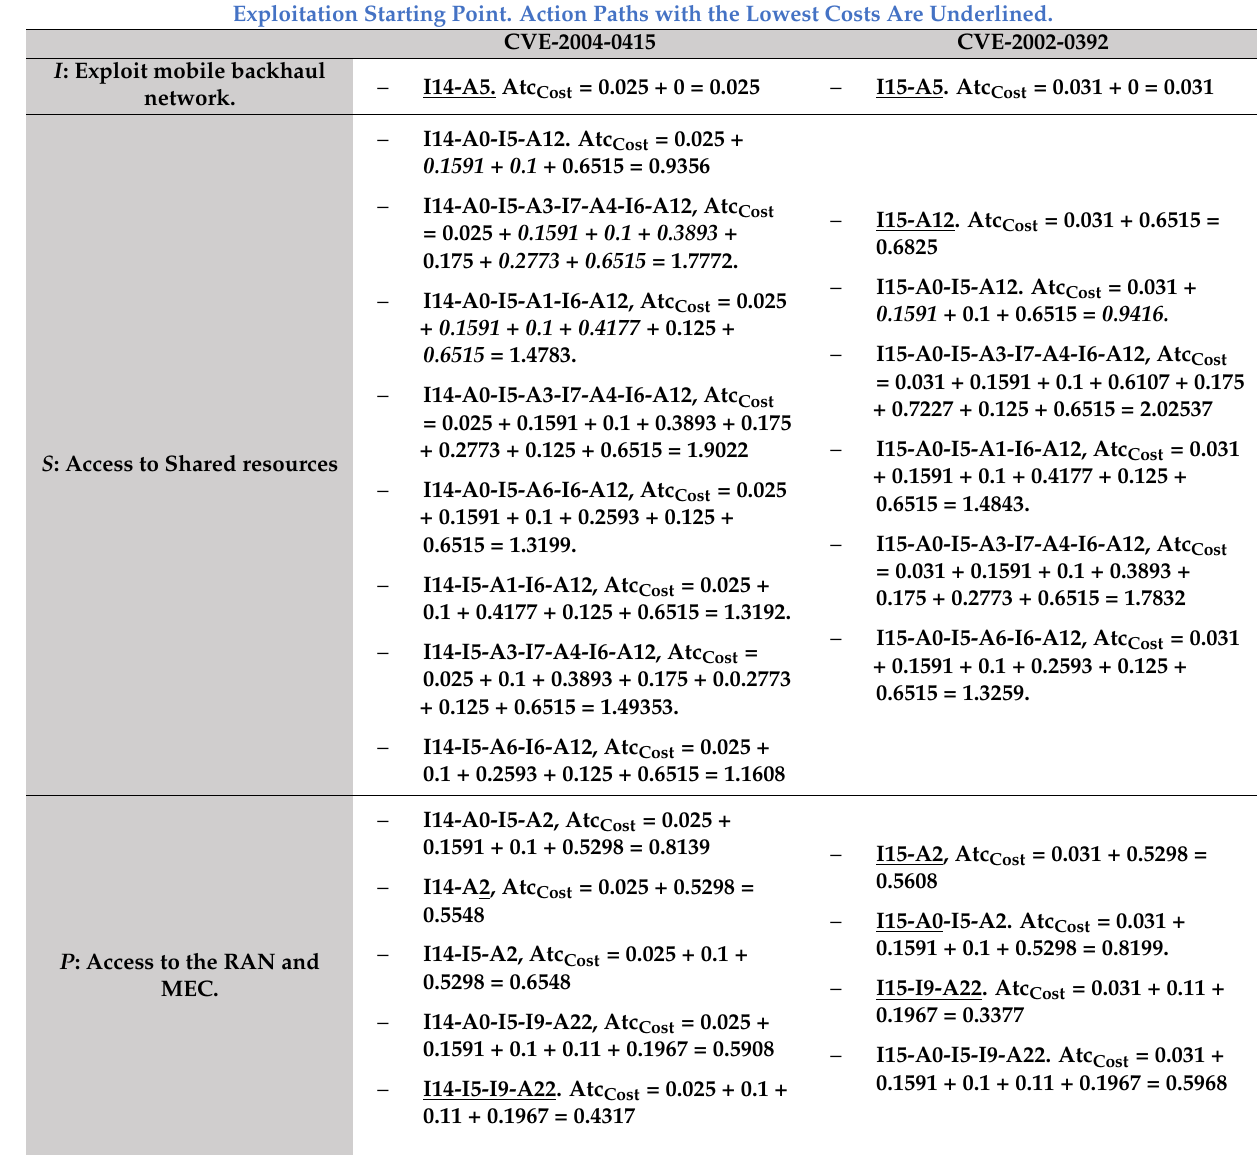
Table 13. The cost and benefits of the attack paths for two exploitation starting points. Exploitation Starting Point. Action Paths with the Lowest Costs Are